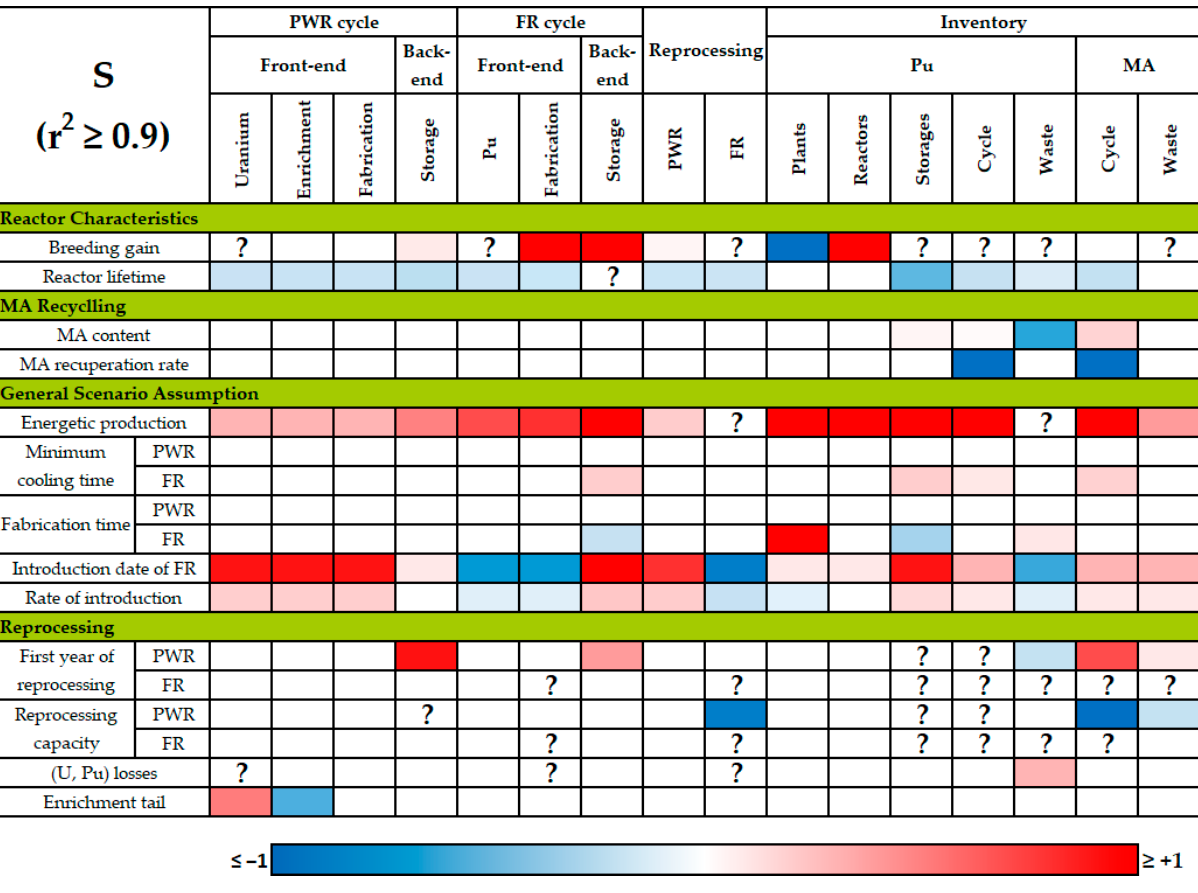
Figure 3. Results of a sensitivity analysis of key output parameters to input parameters used in fuel cycle models, undertaken by the OECD-NEA. Red indicates a positive sensitivity coefficient, meaning that an increase of the input parameter induces an increase of the output parameter. Blue indicates a negative sensitivity coefficient, meaning that an increase of the input parameter induces a decrease of the output parameter. When r 2 is lower than 0.9, the related sensitivity indicator is replaced by a question mark “?”. Redrawn from data in [48].